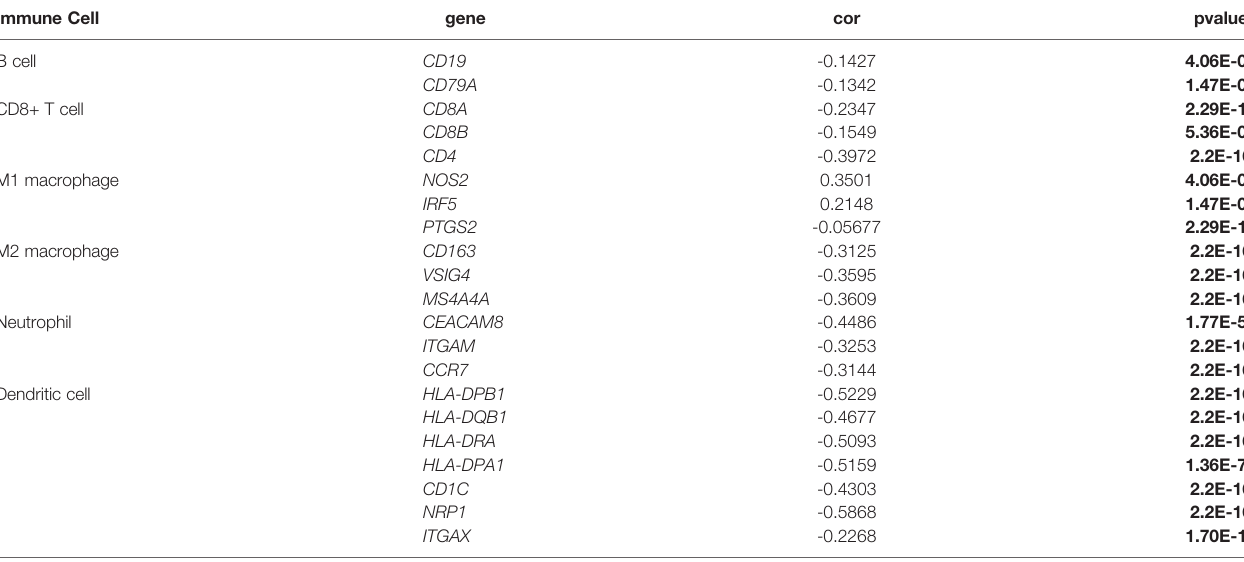
TABLE 4 | Correlation analysis of SLC6A8 expression and immune cell surface marker genes. Immune